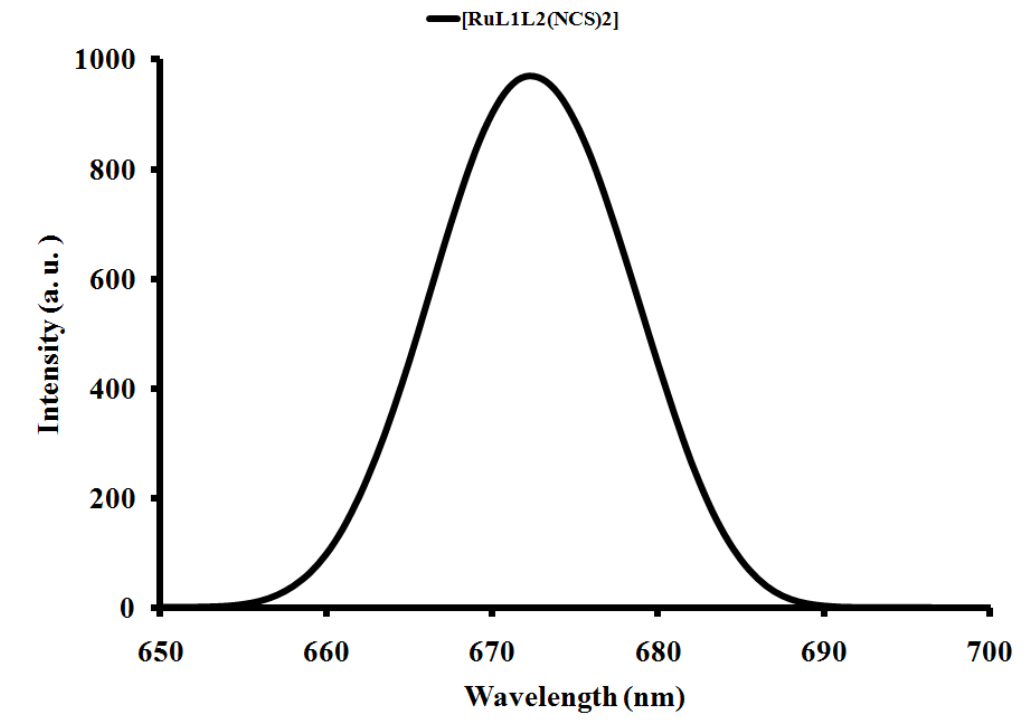
L (NCS) ] in DMF 1 2 2